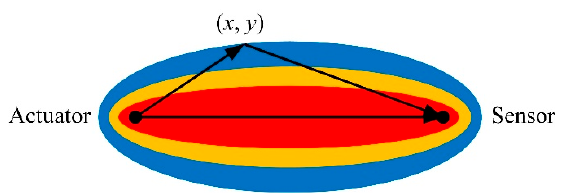
Figure 1. The elliptical distribution function of the reconstruction algorithm for the probabilistic inspection of damage (RAPID).